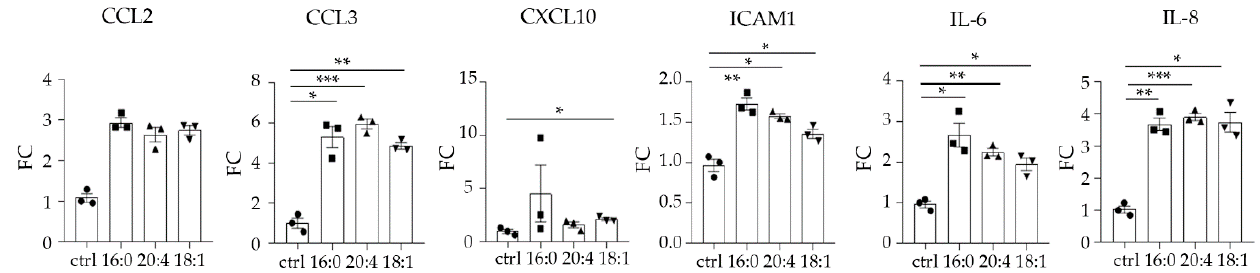
Figure 4. LPA stimulates the secretion of CCL2, CCL3, CXCL10, ICAM1, IL-6, and IL-8 from human kidney proximal tubular epithelial cells (HKC-8). Multiplex ELISA quantifying the expression of the indicated secreted factors in the supernatants from HKC-8 cells upon the stimulation with three different LPA species (16:0, 20:4, 18:1) at 10 μ M for 24 h. Statistical significance was assessed with Brown–Forsythe’s and Welch’s ANOVA followed by Dunnett’s post hoc test in the case of normal distribution or with Kruskal–Wallis test in the case of non-normal distribution; * p < 0.05, ** p < 0.01, *** p < 0.001. Circles correspond to control values, squares correspond to LPA 16:0 values, upward triangles correspond to LPA 20:4 values and downward triangles correspond to LPA 18:1 values.